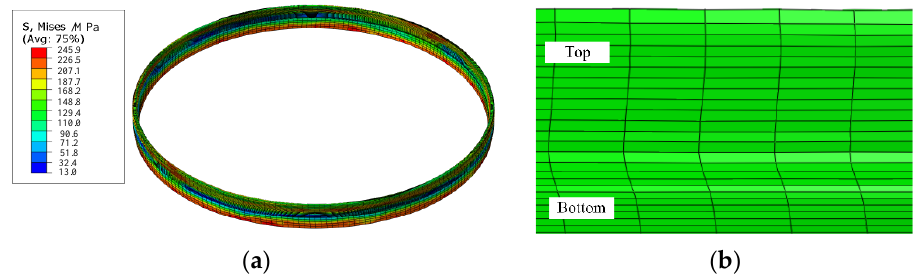
Figure 7. The stress nephogram of the CRFF part: ( a ) Total model; ( b ) Final tube net.